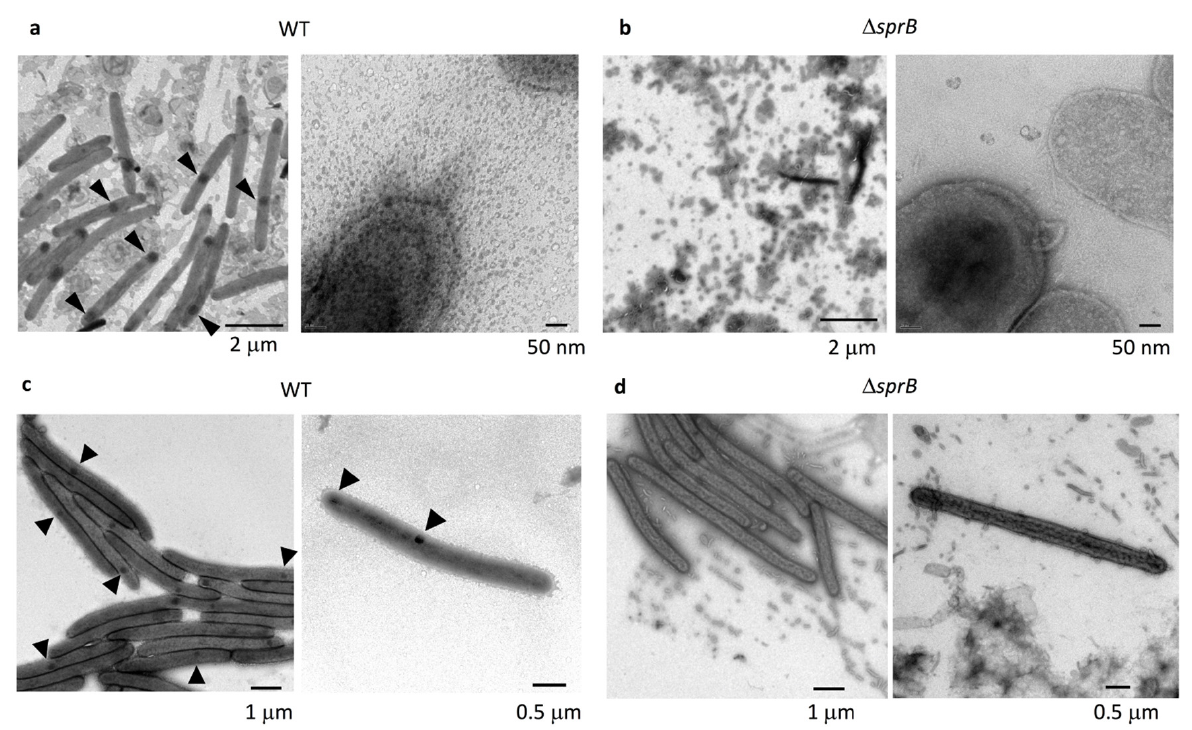
Figure 2. Surface structures at the edge of a WT and a sprB colony. Colony surface at the translucent leading edge of a WT colony was sampled using the grid stamp method (position of Figure 1b, Grid 2), negatively stained, and imaged by TEM. ( a , c ) WT and ( b , d ) sprB colonies on 1% A-PY2. (Left) Low magnification images. (Right) Higher magnification images. ( a ) WT cells were interspersed or ( c ) made head-to-tail and/or side-to-side contact. In both cases, the cells were surrounded by many small vesicles and filaments. ( b , d ) sprB cells at the edge of the small nonspreading colony were found interspersed among thin extracellular fibers and a small number of vesicles. One or two dark spots (arrowheads) were seen in each WT cell ( a , c ), but not in sprB cells ( b , d ).